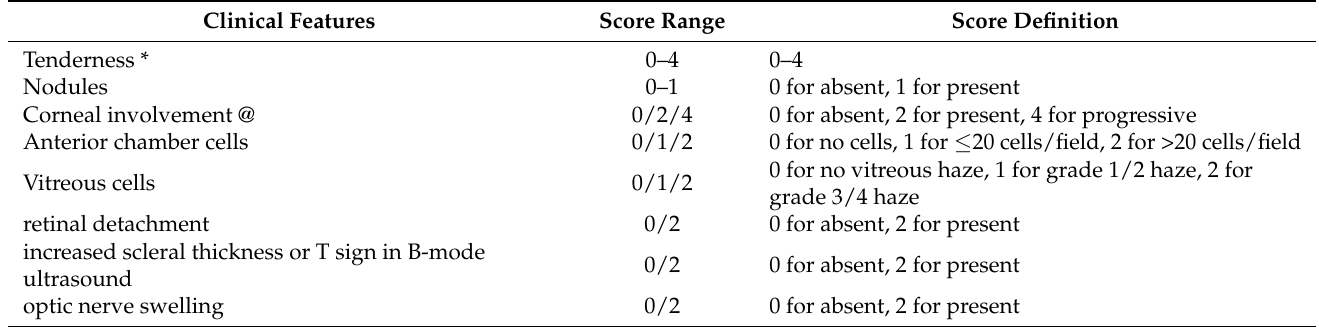
Table A2. The modified McCluskey’s scleritis disease grading